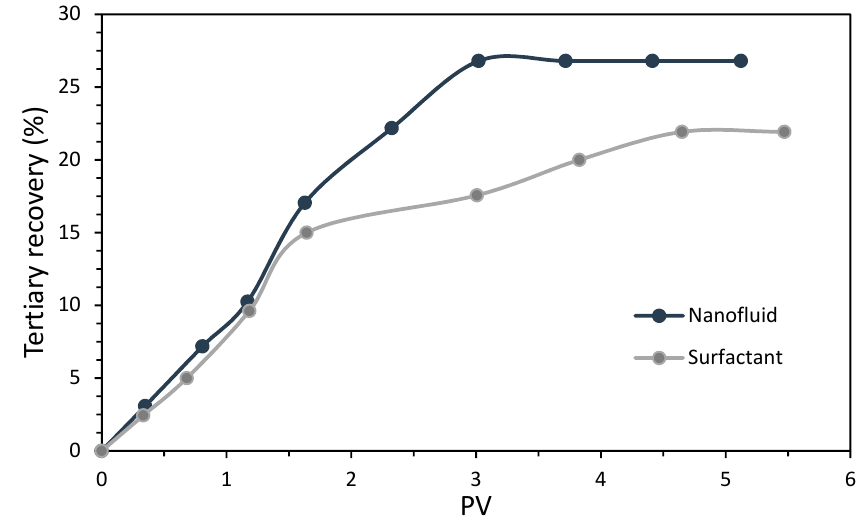
Figure 16. Tertiary recovery estimated for separate injections of the surfactant and nanofluid under reservoir conditions (50 °C, and 9.31 and 3.45 MPa of overburden and back pressure, respectively).